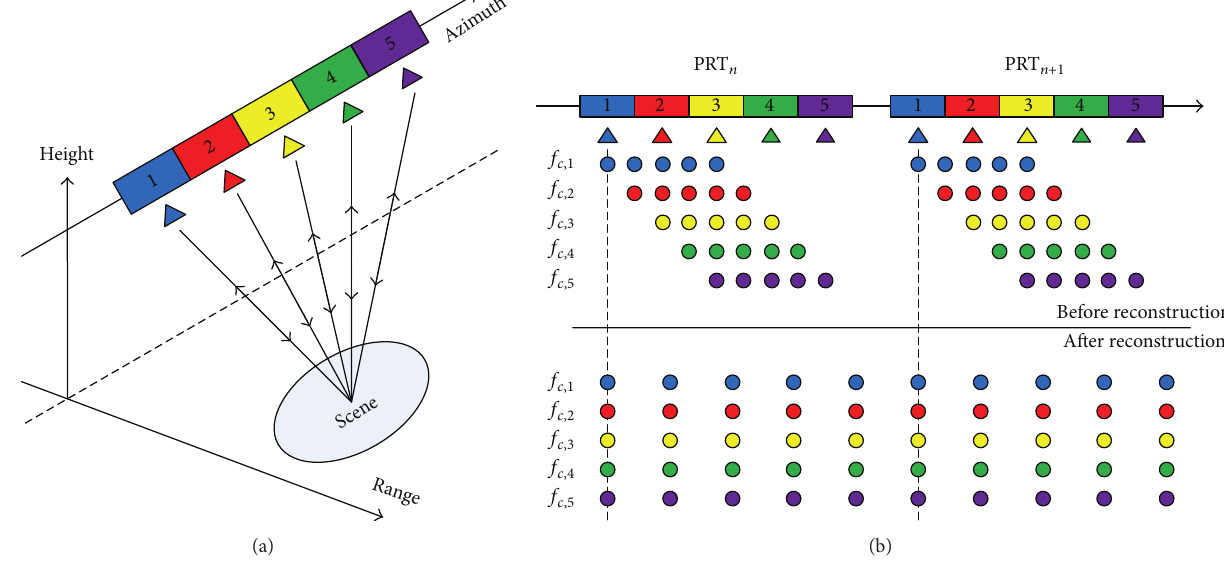
Figure 1: Diagram of a MIMO-SAR system. (a) System geometry. (b) Phase sequence.